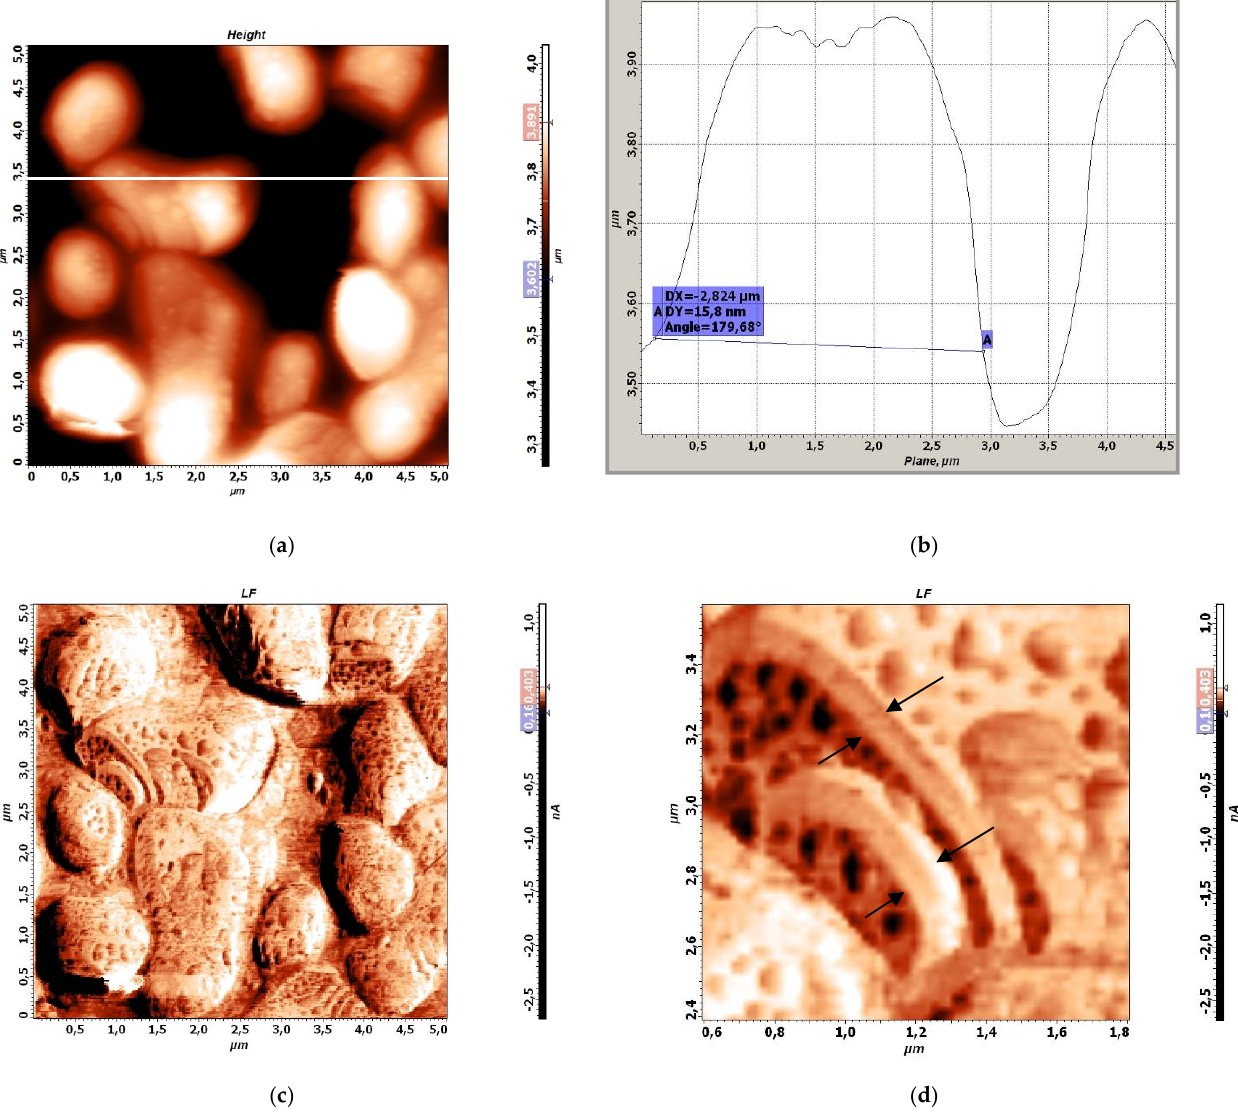
Figure 2. Experimental data of AFM of the photosensitive polycrystalline layer Pb 1 − x Cd x Se <I> (x = 0.18) after plowing (force) lithography by AFM: ( a ) topography map (overall view of the surface), ( b ) the height profile along the line shown ( a ), ( c ) lateral force microscopy image recorded simultaneously with surface topography at ( a ) for the same sample area ( d ) image of a cross-section of an individual grain (arrows show the cross-section of oxidized layer covering the grains).